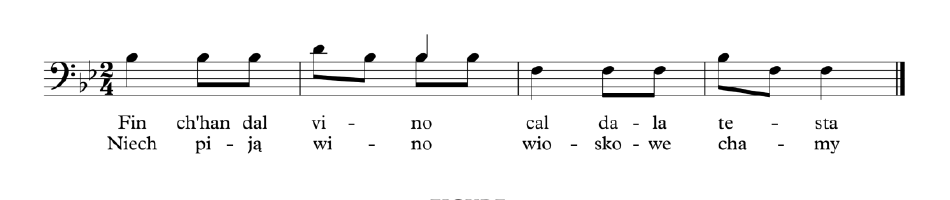
figure 2 The first bars of the aria Fin ch’han dal vino (original by L. Da Ponte and translation by S.